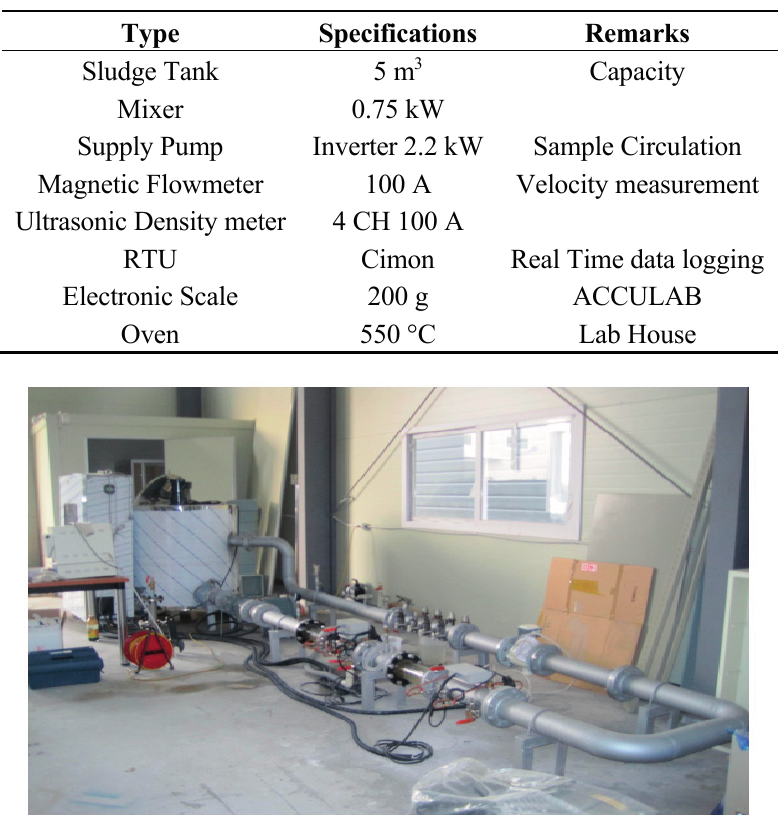
Table 2. Major facilities of the pilot plant.